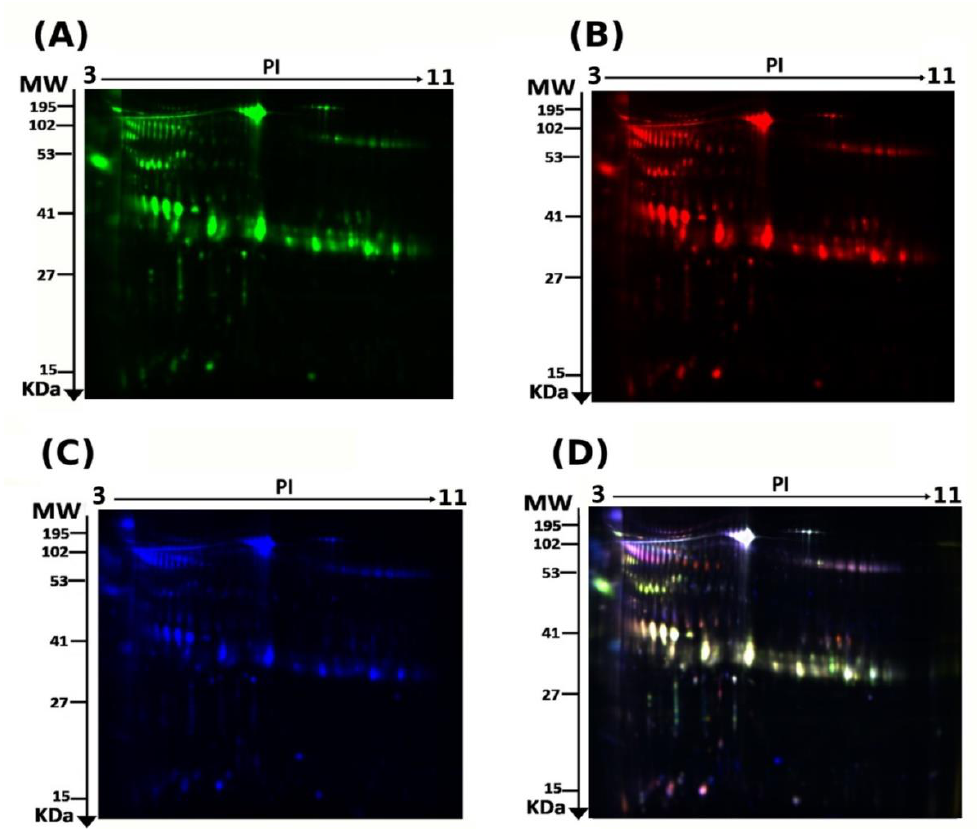
Figure 1. 2D-DIGE analysis and identification of differentially expressed proteins. Representative fluorescent protein profiles of a 2D-DIGE containing euthyroid samples labeled with Cy3 ( A ), hyperthyroid labeled with Cy5 ( B ), and pooled internal control labeled with Cy2 ( C ), Merged 2D-DIGE comparison of Cy3/ Cy5 ( D ). Urine proteins were separated on IPG strip (pH 3 – 11) in the first dimension followed by 12.5% PAGE in the second-dimension gel electrophoresis. Images were captured using a Typhoon 9400 Variable Mode Image.